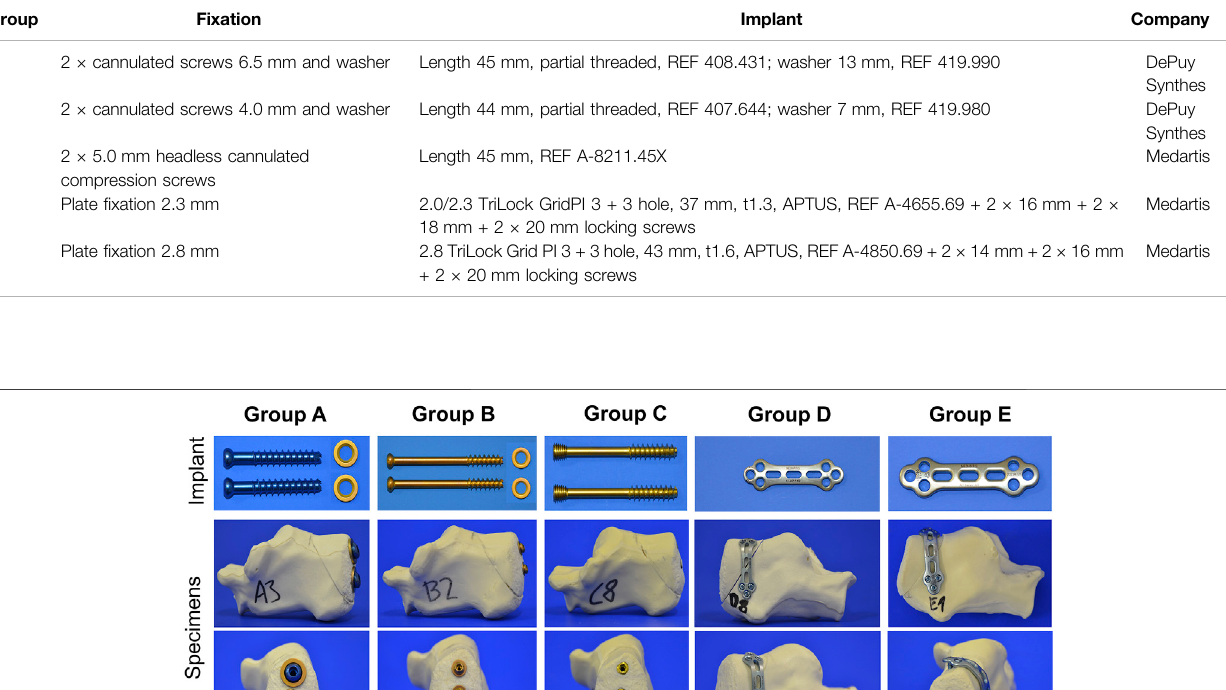
TABLE 1 | Different groups tested. Group Fixation